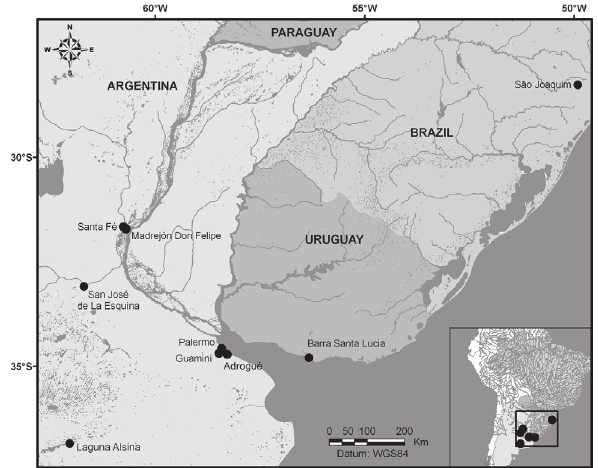
Figure 1. Geographical distribution of Argyrodiaptomus bergi . Indi- vidual localities are listed in table I.